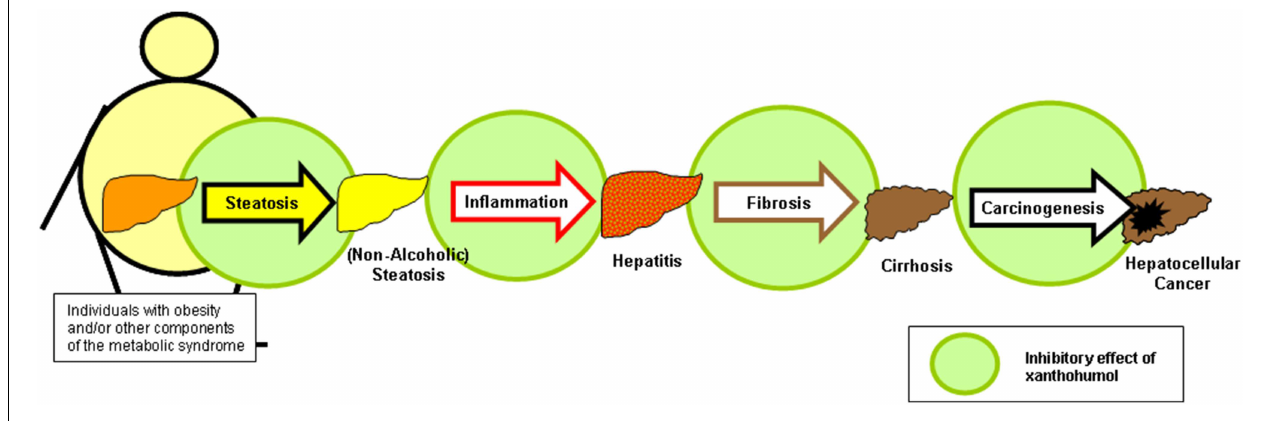
FIGURE 4 | Xanthohumol effects on different pathophysiological factors during the course of non-alcoholic fatty liver disease. Xanthohumol (XN) has the potential to inhibit hepatic steatosis, inflammation, fibrosis and even the causes of liver injury by interaction on different levels,